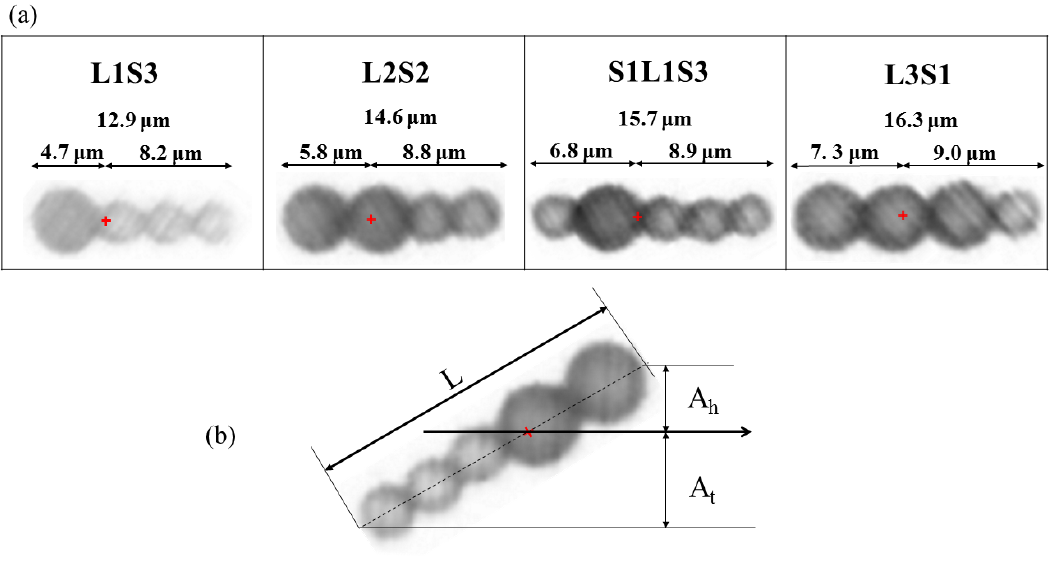
Figure 10. ( a ) Schematic diagram of the configuration of the different types of swimmers. ( b ) Definition of the oscillating amplitude of the head ( A h ) and the tail ( A t ) for a swimmer. A h is the distance measured from the tip of the head particle to the center of the mass of the swimmer; A t is the distance between the tip of the tail particle and the center of the mass of the swimmer; L represents the overall length of the swimmer.